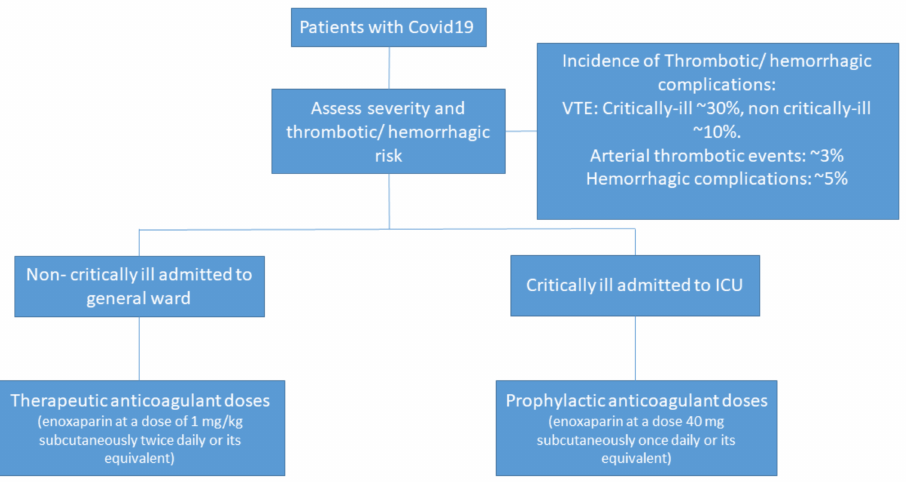
Figure 2. Initial clinical management. Abbreviations: ICU = Intensive care unit; VTE = venous